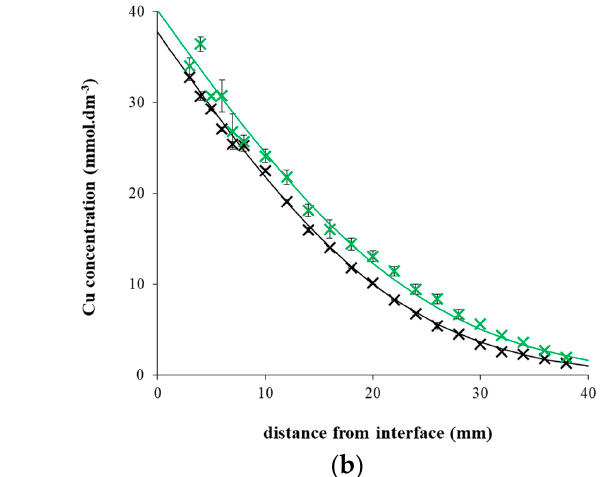
Figure 1. ( a ) Concentration profiles of copper(II) ions in agarose hydrogel enriched by chitosan (0.5 mg g − 1 ) after 24 h (blue) and 72 h (red). ( b ) Concentration profiles of copper(II) ions in pure agarose hydrogel (black) and hydrogel enriched by chitosan (1 mg g − 1 ; green) after 72 h. Experimental data are fitted by Equation (1). Table 1. Initial and boundary conditions of diffusion experiments.